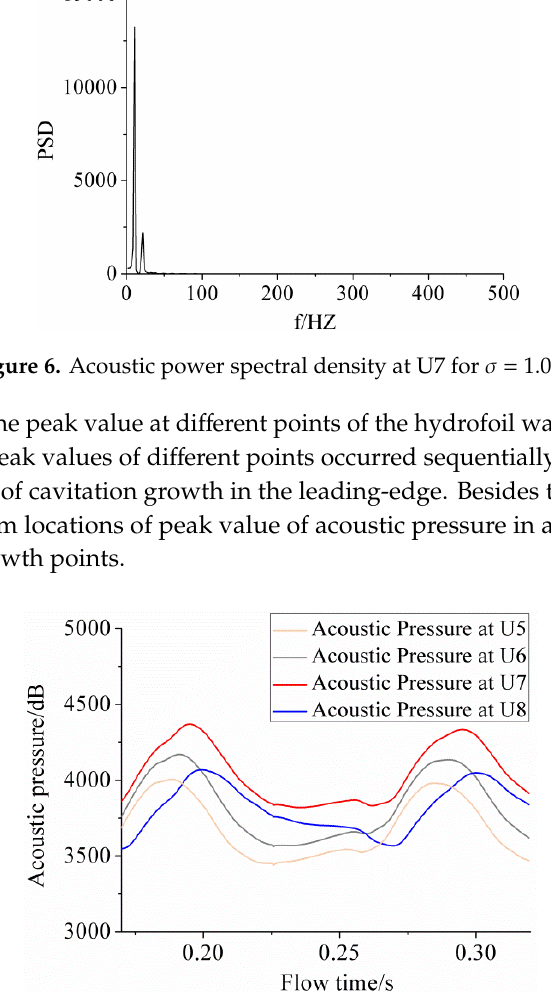
Figure 7. Acoustic pressure pulsation at different locations for σ = 1.075.